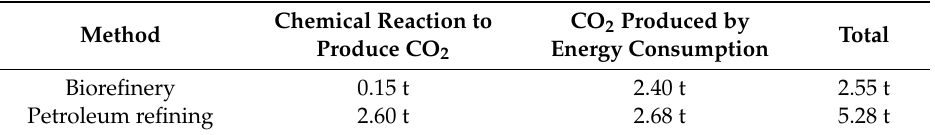
Figure 1. Petroleum refining and biorefining to produce polyols. Table 1. CO 2 emission data of 1 t ethanediol production.